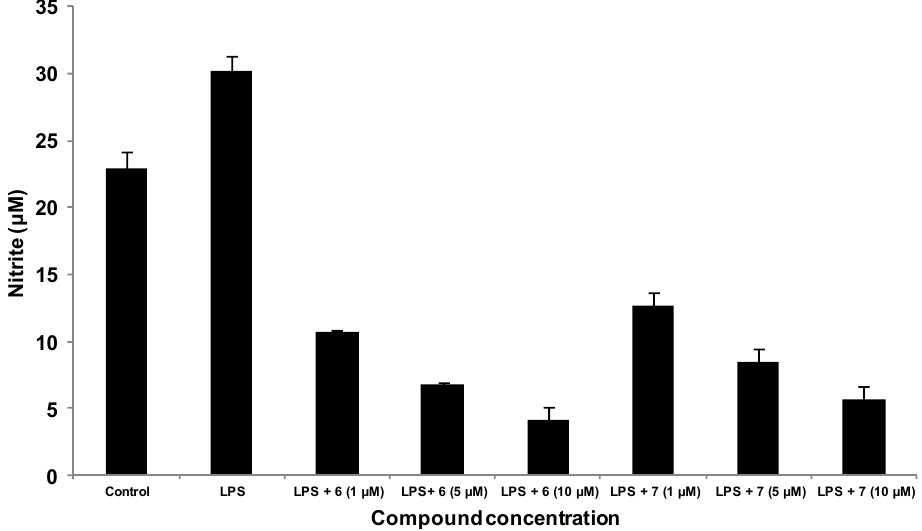
Figure 5. Effect of 6 and 7 isolated from P. longifolia var. pedula on cell viability. RAW 264.7 macrophages (5 × 10 3 /well) were treated with compounds 6 and 7 , DMSO (control) in the presence or absence of LPS (1 µg/mL) for 24 h, followed by incubating with MTT reagent. After 30 min of incubation, the absorbance ( A by spectrophotometry [26]. The data were expressed as the means ± S.E. from three separate